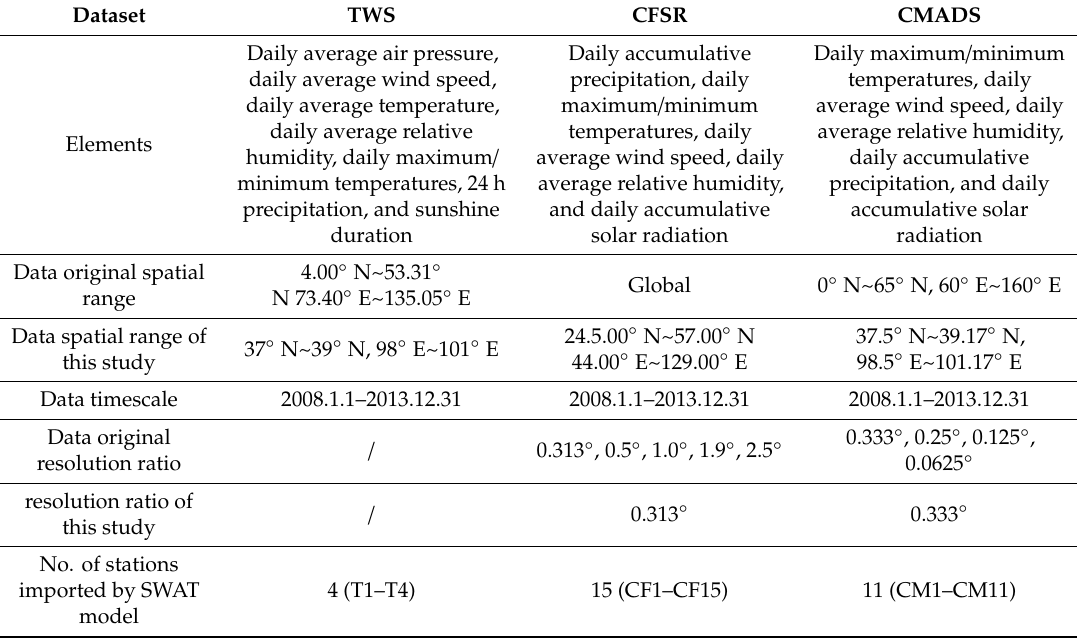
Table 2. Three types of atmospheric forcing data: Traditional Weather Station (TWS), Climate Forecast System Reanalysis (CFSR), and China Meteorological Assimilation Driving Datasets for the SWAT model